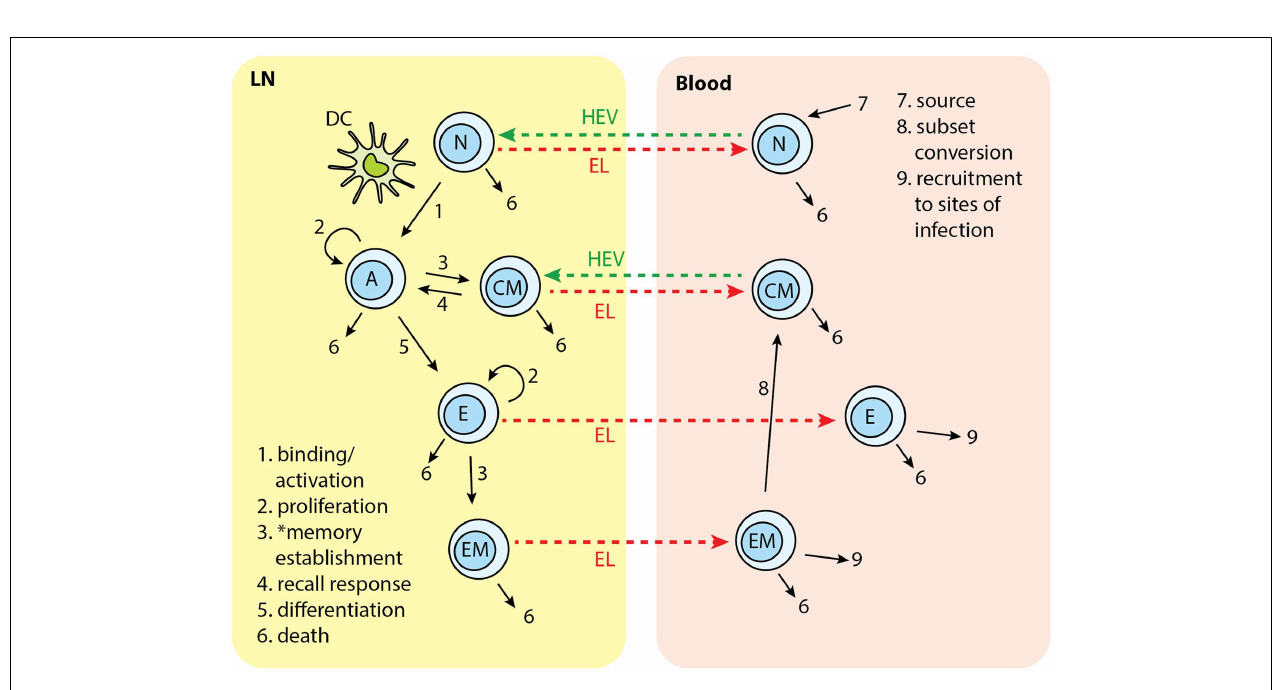
and effector cells. CM in the LN can bind to DC and be activated again. EffectorT cells can further differentiate to effector memory (EM) cells. Naïve, effector, CM, and EM exit LN from EL. Naïve and CM cells recirculate between LN and blood. Effector and EM are recruited to sites of infection. EM can covert to CMs. *Memory establishment for CD8 + T cells requires LDCs.